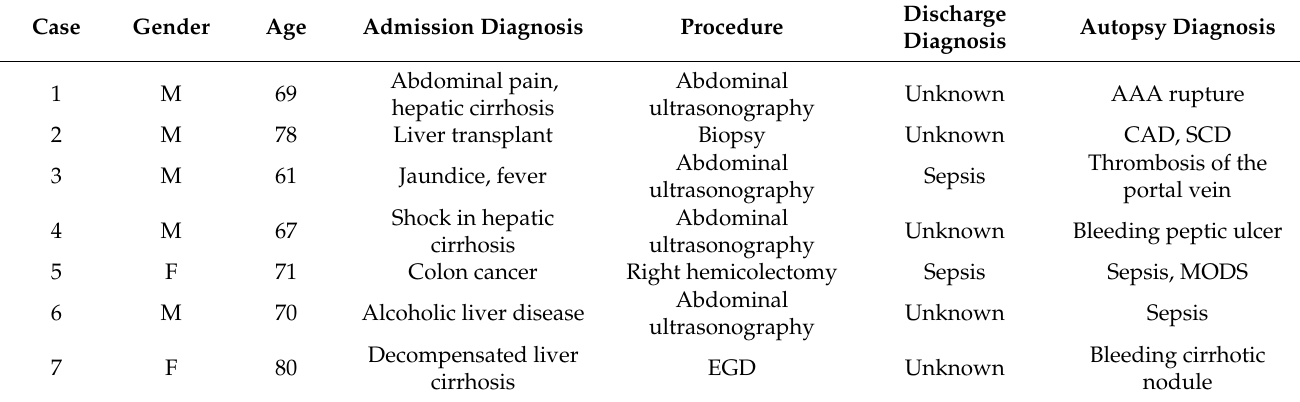
Table 1. Summary of the 28 cases included in the